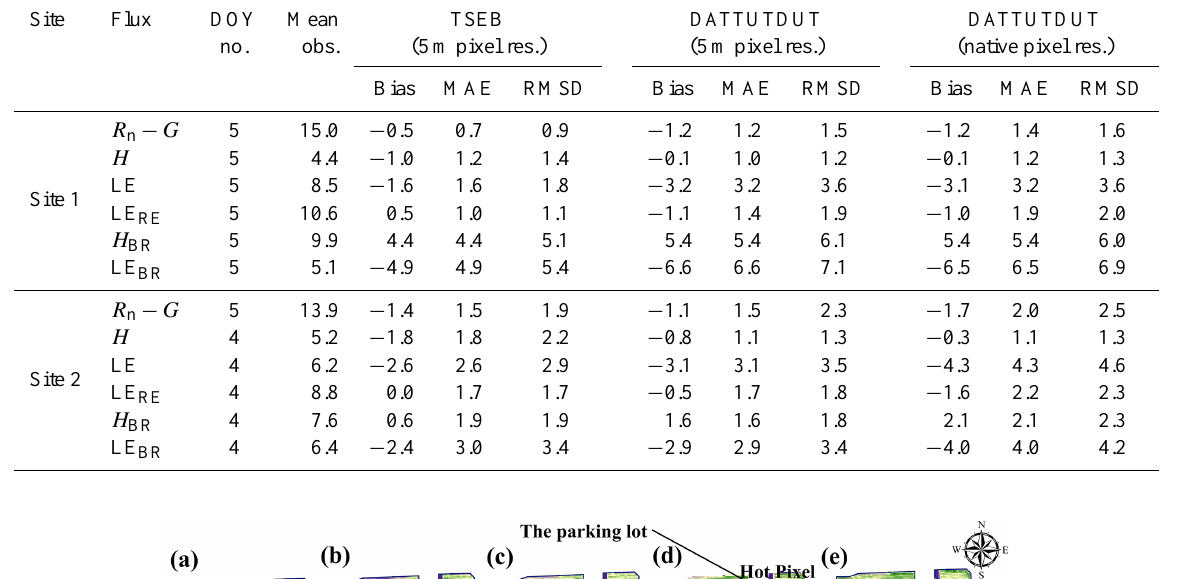
Table 3. Difference statistics describing comparisons between modeled daytime fluxes from TSEB and DATTUTDUT model and observa- tions (original and with adjustments using the RE and BR methods) (MJm − 2 day − 1 ).